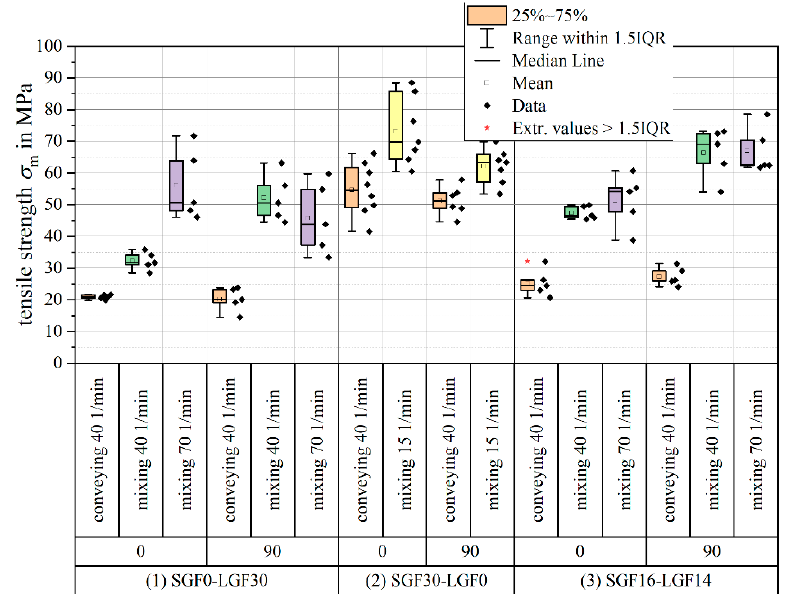
Figure 11. Tensile strength of 30 wt.-% specimens (usage and extension of the results presented in [57,58]). in [57,58]).